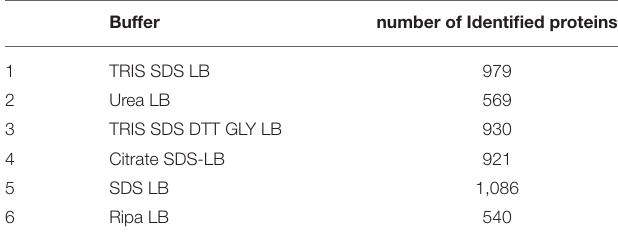
FIGURE 4 | Evaluation of the minimal sample amount necessary to obtain good quality protein using 1.5 and 3.5mg of tissue. 1D SDS-PAGE 10% gel was performed to evaluate the protein integrity. Visualization of gel protein bands after the deparaffinization of with xylene at RT using two protein extraction SDS-containing buffers: buffer 3 (TRIS SDS DTT GLY LB) and buffer 5 (SDS LB). All samples were treated under the conditions of protocol 3 (disaggregation with the TissueLyser). TABLE 3 | Number of identified proteins by LC-MS/MS using the six different extraction buffers. There are shown the number of common proteins identified in all replicates ( × 3).